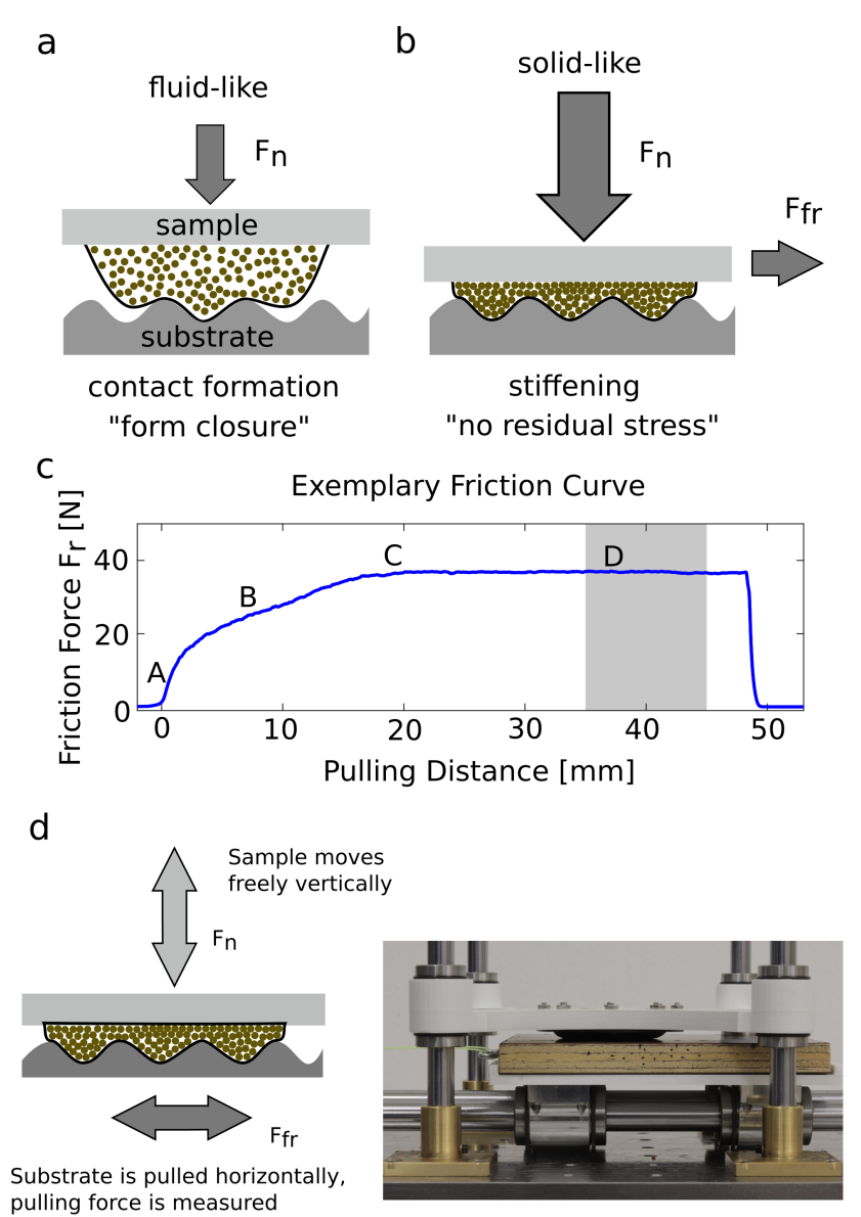
Figure 1. Granular media friction pad (GMFP) [1]. ( a ). Fluid-like state upon coming into contact. ( b ). Solid-like state under high normal load. ( c ). Exemplary friction curve. ( d ). Experimental setup.